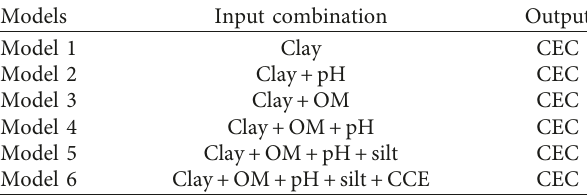
Table 2: Input-Output structures for model